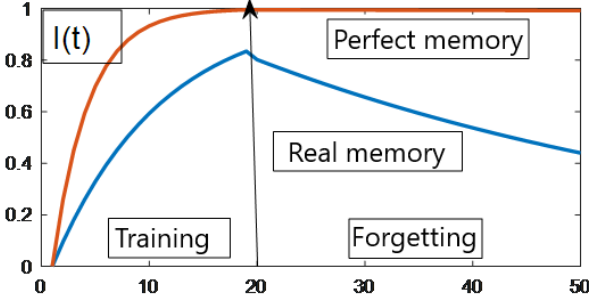
Fig. 5. The construction of learning-forgetting functions according to Shlensky O.F. and Bode B.V.